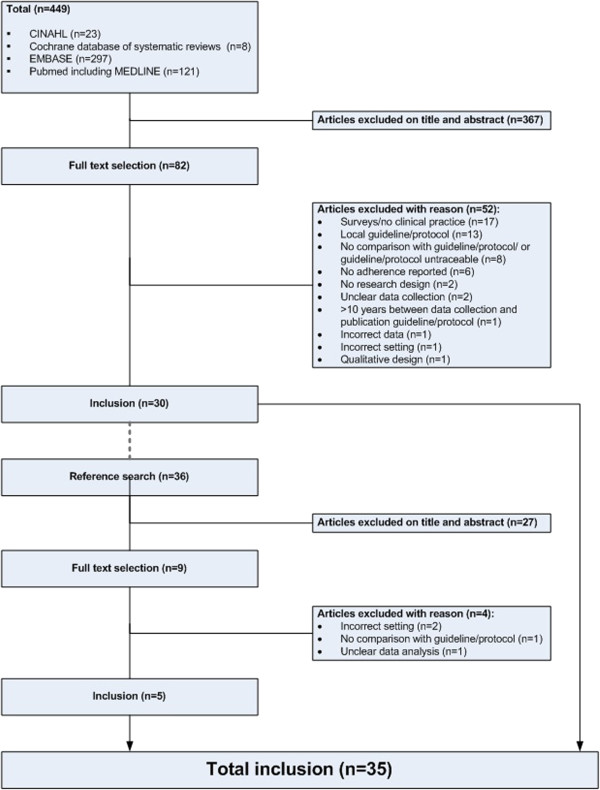
Inclusion of studies.